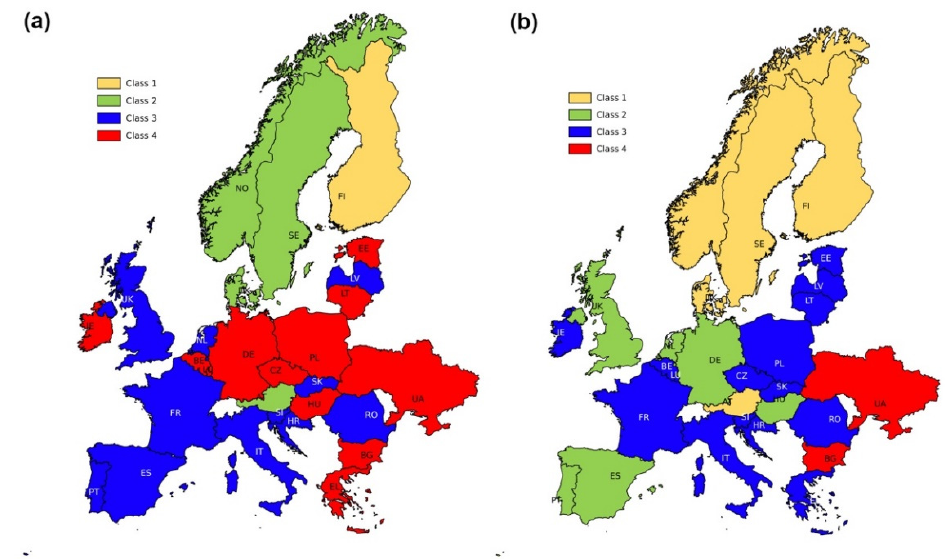
Energies 2021 , 14 , x FOR PEER REVIEW 16 of 25 Figure 6. Results of the VMCM classification of European countries regarding renewable energy production with reference to the 2009 artificial pattern: ( a ) year 2001; ( b ) year 2009.